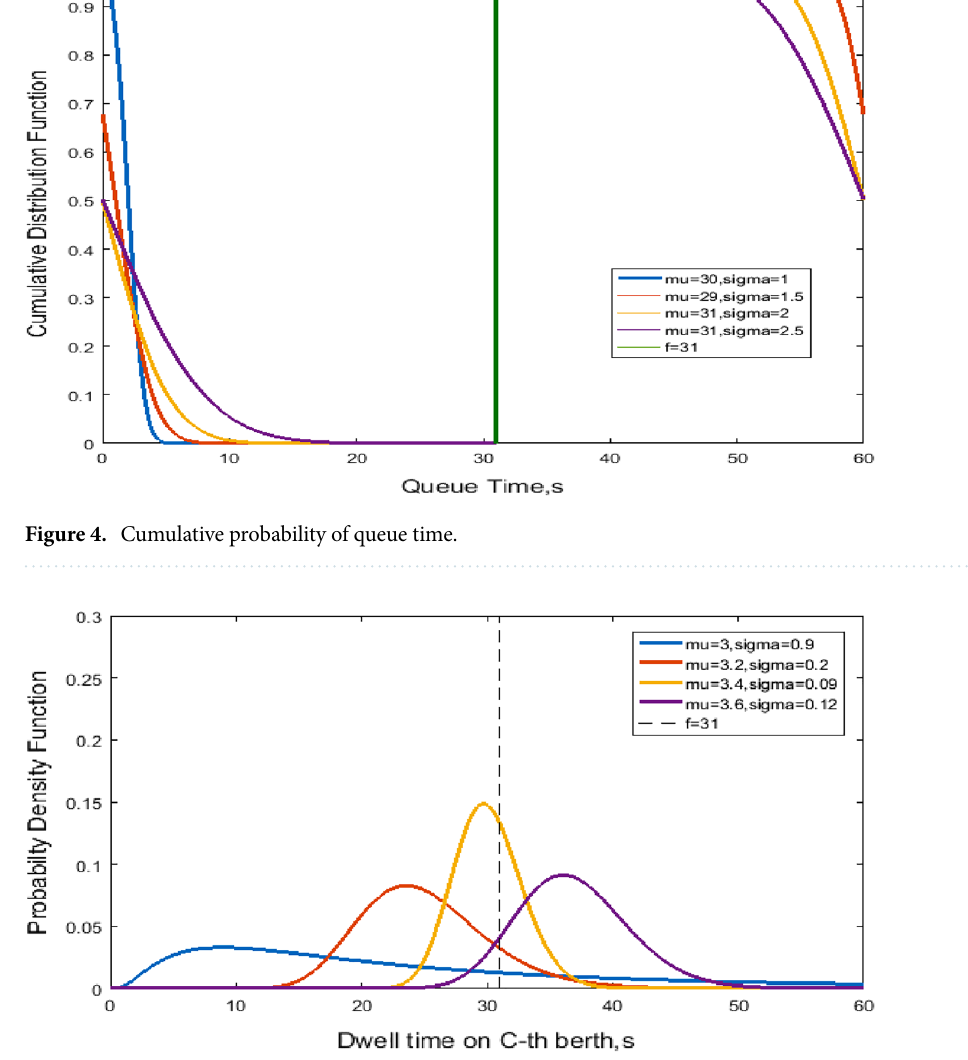
Figure 5. Lognormal distribution of dwell time at the C-th berth.